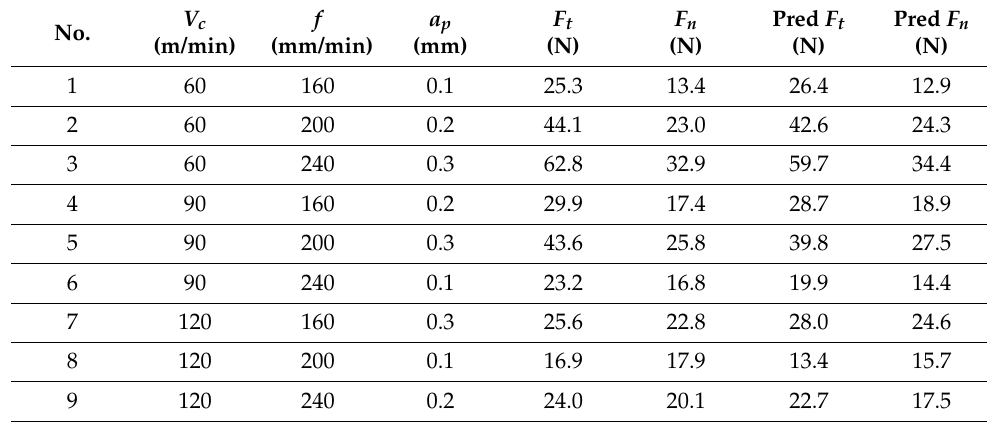
Figure 6. Low frequency filtering of the milling force signal. ( a ) Before FFT. ( b ) After FFT. The experimental parameters and results under the condition of dry milling are shown in Table 9. Table 9. Experimental results of Ti-6Al-4V under dry milling.